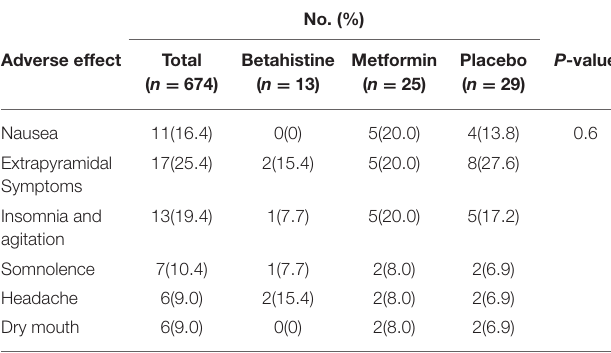
TABLE 4 | Adverse effects of three